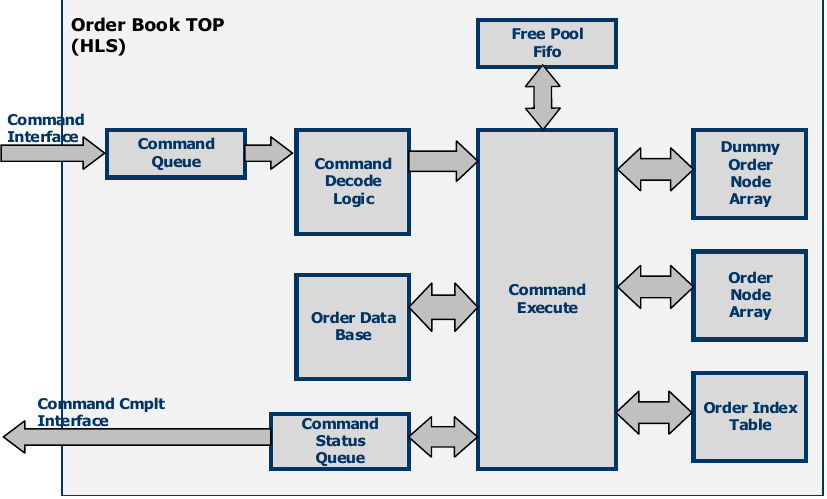
Figure 7. Block diagram of the order processing block implemented in HLS.